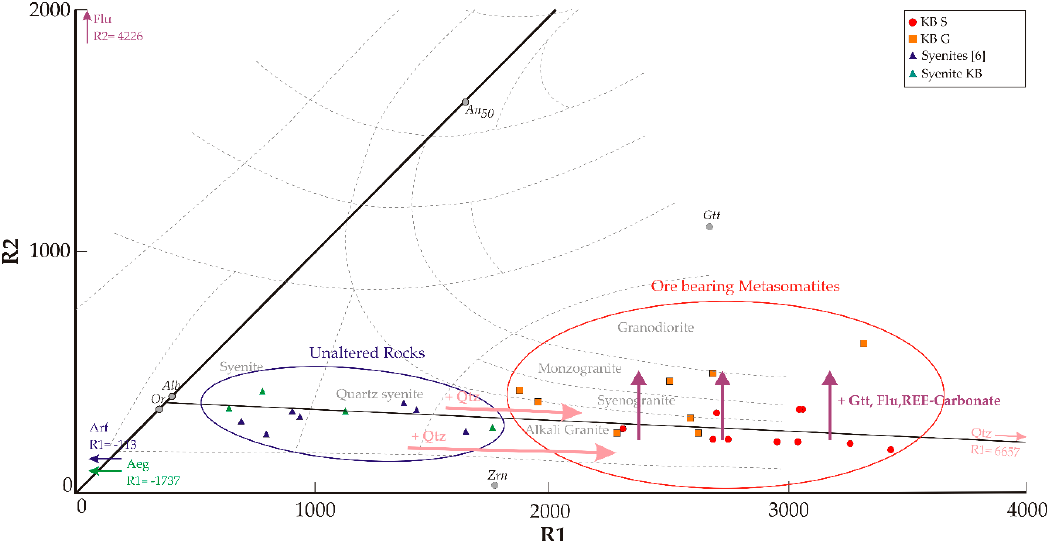
Figure 8. R1-R2 multication plot of the KB G and S samples, classification after [21] indicated by stippled grey lines. Fluorite (Flu) and quartz (Qtz) compositions plot outside the diagram and are indicated by their R1 and R2 value at the hosting axis. The blue mark indicates unaltered rocks of the Khalzan Buregtei Massif according to [5] (Syenites [5]) and Gronen (unpublished) (Syenite KB). Red mark highlights ore bearing metasomatic rocks of the KB S and KB G dataset. Purple vectors indicate the change of R2 value of samples containing CaO > 1.8 wt. %. Mineral abbreviations: Zrn = zircon, Gtt = gittinsite, Alb = albite, An 50 = anorthite, Or = orthoclase K-feldspar, Arf = arfvedsonite, Aeg = aegirine. Composition of Arf and Aeg according to [24].